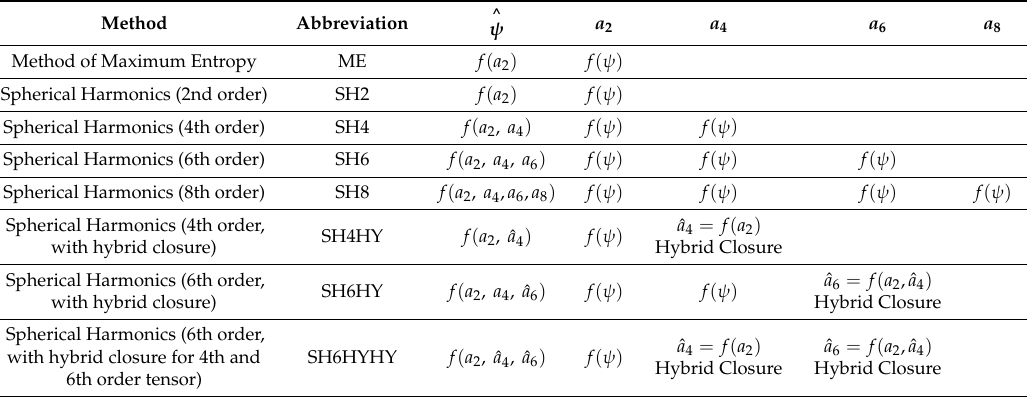
Table 4. List of used reconstruction methods and their